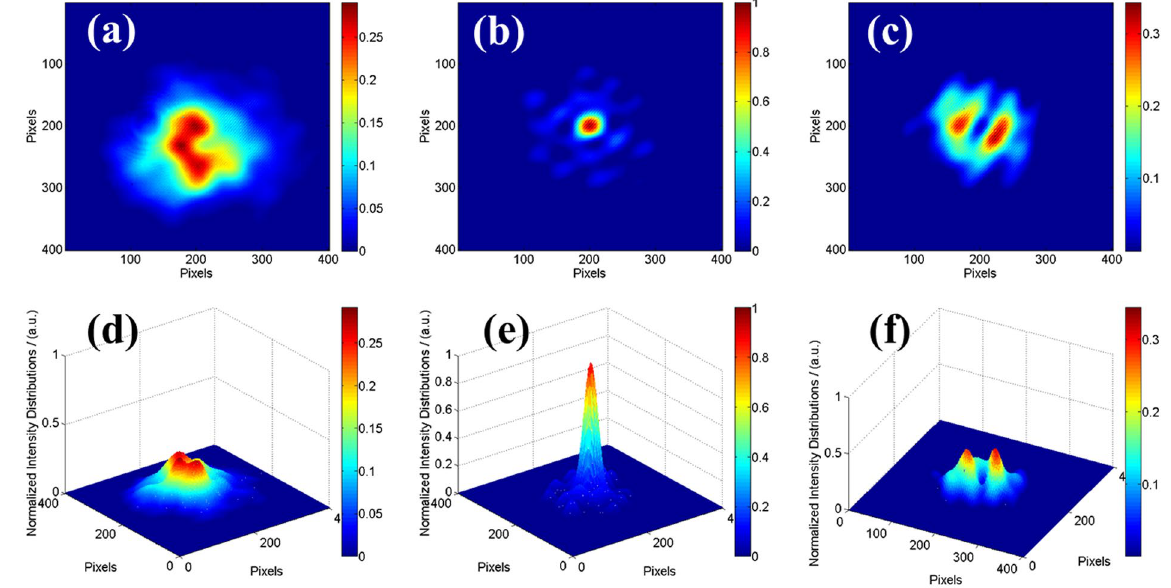
Figure 7. The long exposure beam pattern in different situations. ( a )~( c ) Two dimensional intensity distributions. ( d )~( f ) Three dimensional intensity distributions.